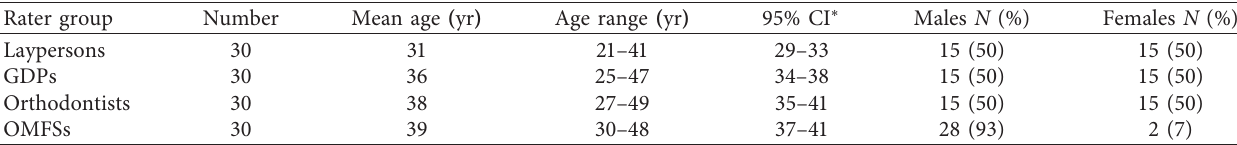
Figure 2: Baseline and manipulated images to affect decreased and increased LAFH ratios to the face height. Table 1: Rater demographics.